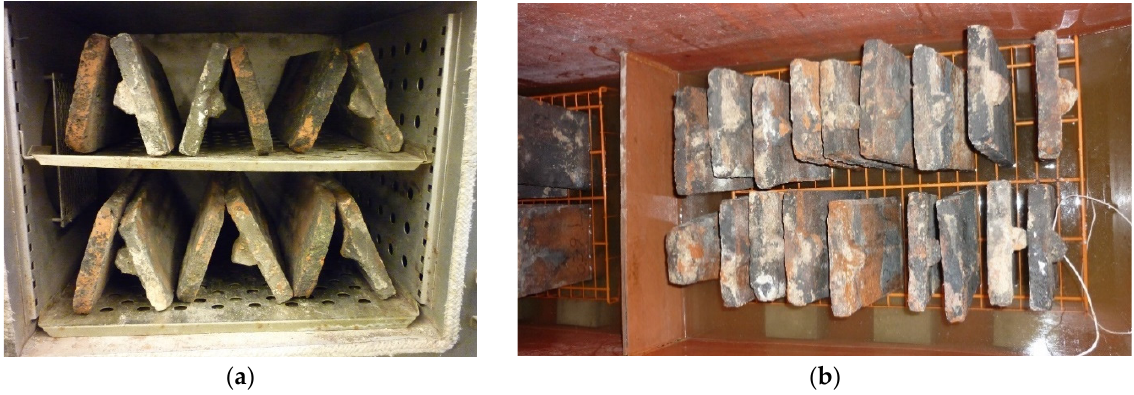
Figure 5. Absorption test: ( a ) drying of tiles to constant weight at a temperature of 110 °C +/ − 5 °C; ( b ) roof tiles in a chamber with 100% humidity.